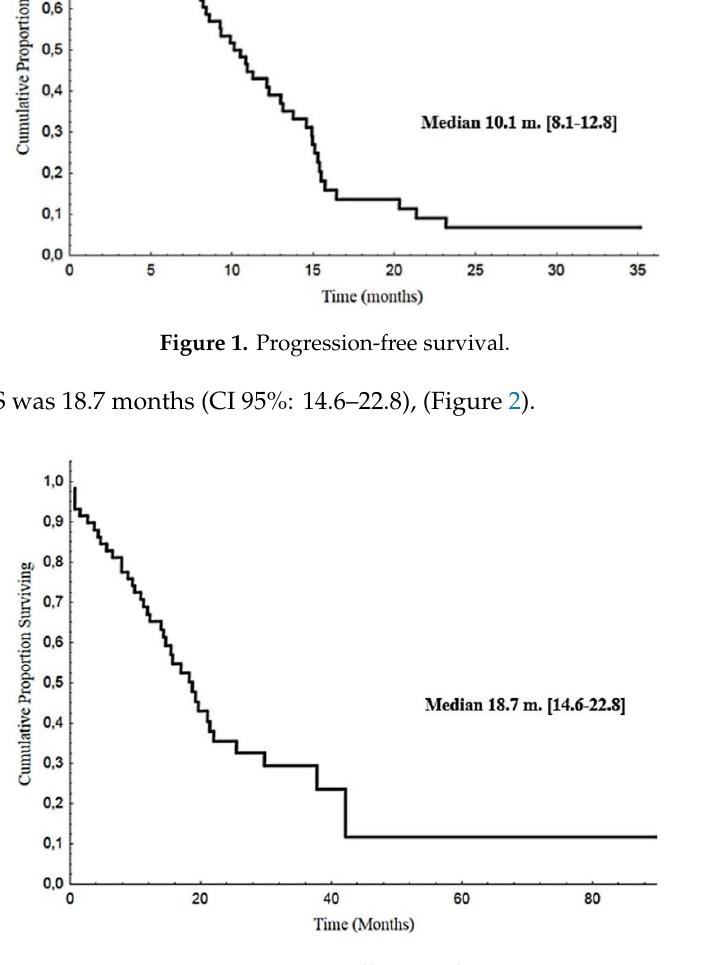
Figure 2. Overall survival.